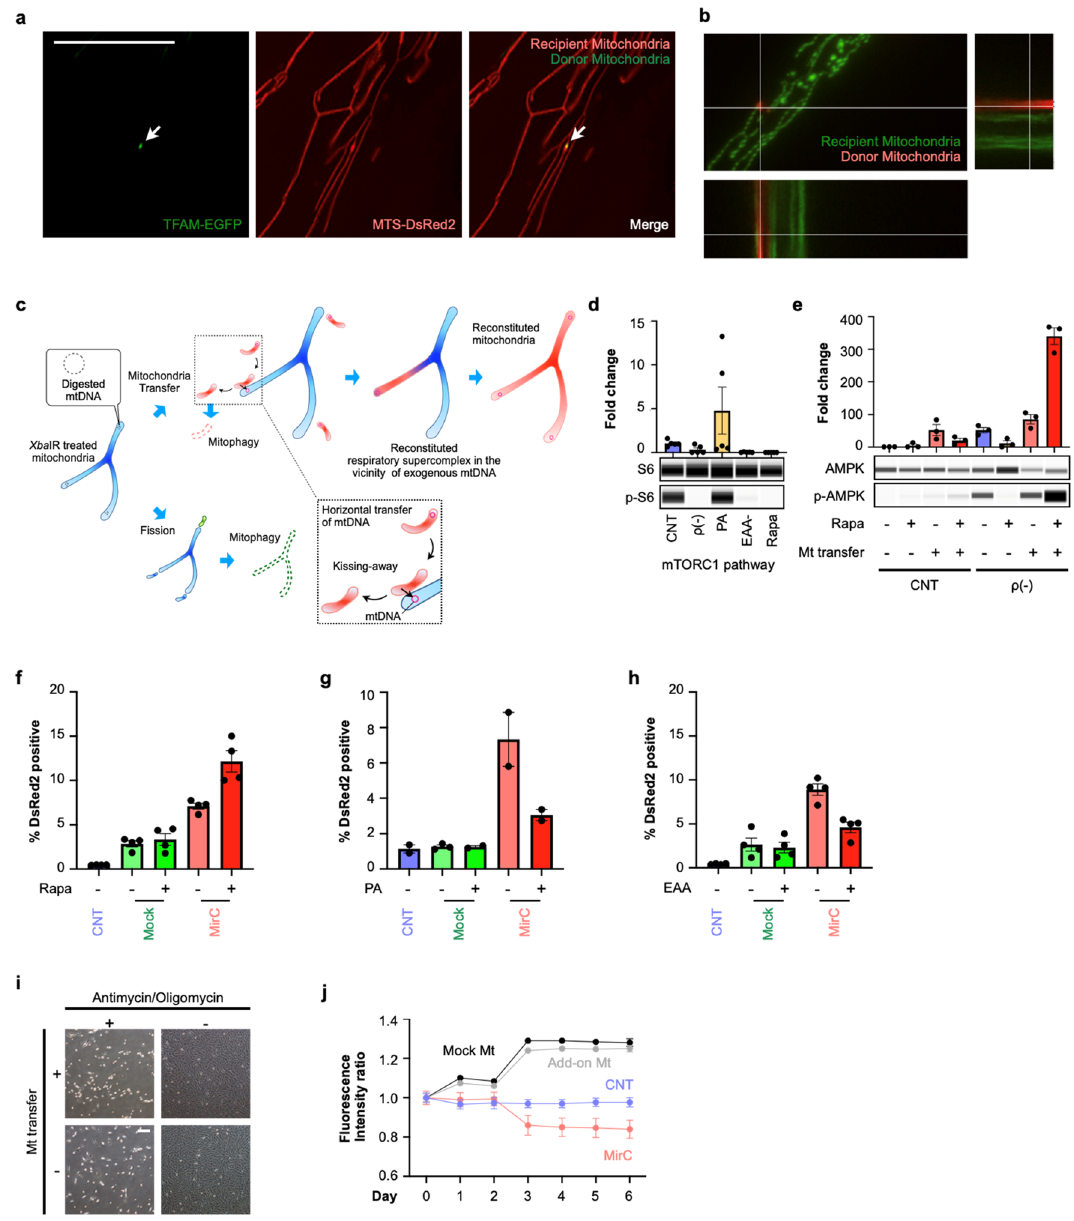
Figure 4. Mechanistic insights into the process of mtDNA replacement. ( a ) Superfine microscopy showed that exogenous mtDNA coupled with TFAM, which was genetically fused with EGFP, existed in endogenous mitochondria, which were genetically marked with DsRed. White bar indicates 50 µm. ( b ) Fibroblasts with EGFP marked mitochondria were subjected to MirC generation protocol with DsRed-marked mitochondria. Following the coculture, two fluorescence signals were always far apart and showed temporary contact for a short period. ( c ) A model of “Kissing away” in transferring mtDNA into endogenous mitochondria. ( d ) Activation of mTORC1 was measured by the ratio of phosphorylation of S6 to S6. ρ(-) cells derived from NHDFs significantly decreased the mTORC1 pathway, similar to that observed in essential amino acid-free medium and rapamycin treatment. (n = 5, respectively). ( e ) AMPK activation during the MirC generation protocol with rapamycin. (n = 3, respectively). ( f ) Rapamycin enhanced the engulfment of exogenous mitochondria in the MirC generation protocol. (n = 3, respectively). ( g ) PA suppressed macropinocytosis in the MirC generation protocol. (n = 3). ( h ) EAA free media suppressed the engulfment of exogenous mitochondria in MirC generation protocol. (n = 3). ( i ) ρ0 cells that completely lacked mtDNAs were generated by adding antimycin and oligomycin to Parkin-overexpressing cells and showed no engulfment of exogenous mitochondria. White bar indicates 200 µm. ( j ) The fate of exogenous mitochondria. Fluorescent area was measured as a surrogate for the fate of exogeneous mitochondrial membranous components. Mock transfectants or cells that were cocultured with isolated mitochondria without mtDNA reduction, designated as add-on, showed the gradual increased intensities, whereas cells subjected to MirC protocol showed diminusion. (n = 3) The full-length gels of cropped gels in d and e are in Supplementary Fig. S6 and S7, respectively. Mock: Mock transfectants that received a plasmid without XbaIR